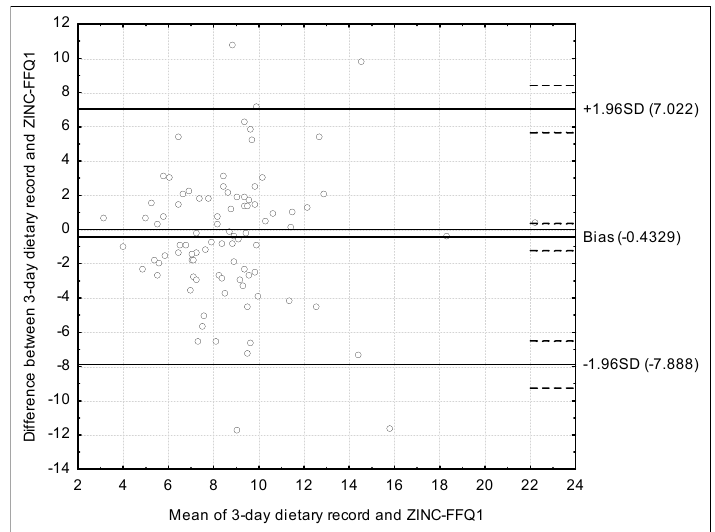
Figure 2. The assessment of the validity of the ZINC-FFQ conducted using the Bland–Altman plot for the ZINC-FFQ1 (Bland–Altman index of 5.5%). ZINC-FFQ1 = first food frequency questionnaire. SD = Standard deviation.